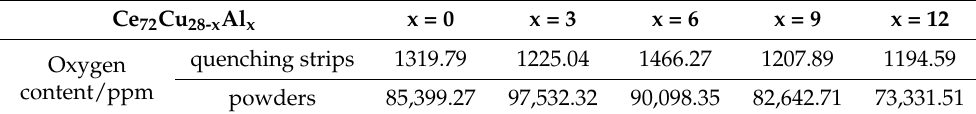
Figure 2. ( a ) Appearance of Ce 72 Cu 28-x Al x alloy ingot, ( b ) rapid quenching strip, and ( c ) micro struc- ture morphology of alloy powder.